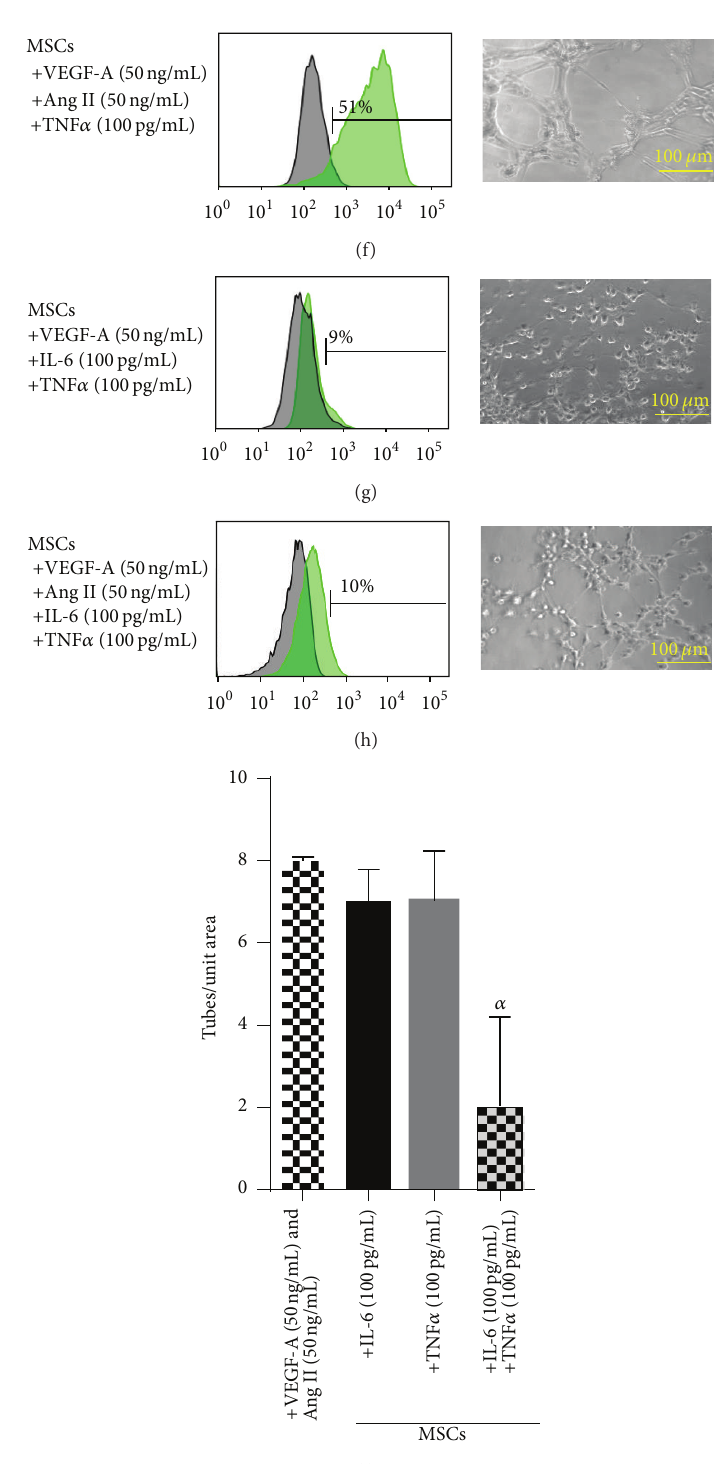
Figure 6: Ang II counteracts IL-6 or TNF 𝛼 inhibition of EC differentiation: the combined effects of Ang II, IL-6, and TNF 𝛼 on VEGF-A- stimulateddifferentiationofMSCsintoECswereexamined.TNF 𝛼 R,IL-6R,AT2R,andVEGFR-2mRNAexpressionwasanalyzedbyRT-PCR ( 𝑛 = 3 ) (a). Sox18 protein levels were measured by Western blot analysis ( 𝑛 = 3 ) (b). Expression of EC markers was determined by FACS analysis, and a representative grid is shown ( 𝑛 = 3-4) ((c)–(h)). Endothelial tube formation was examined using an angiogenesis assay ( 𝑛 = 3 ) ((d)–(i)). Experiments were performed with samples taken from independent BM-MSC cultures from separate microswine. HUVECs were excluded from statistical analyses. Data are shown as mean ± SD. ∗ 𝑝 < 0.05 versus na¨ıve MSCs, # 𝑝 < 0.05 MSCs treated with VEGF-A versus VEGF-A plus Ang II cotreatment, and 𝛼 𝑝 < 0.05 versus MSCs treated with VEGF-A and Ang II versus VEGF-A and Ang II plus IL-6 and/or TNF 𝛼